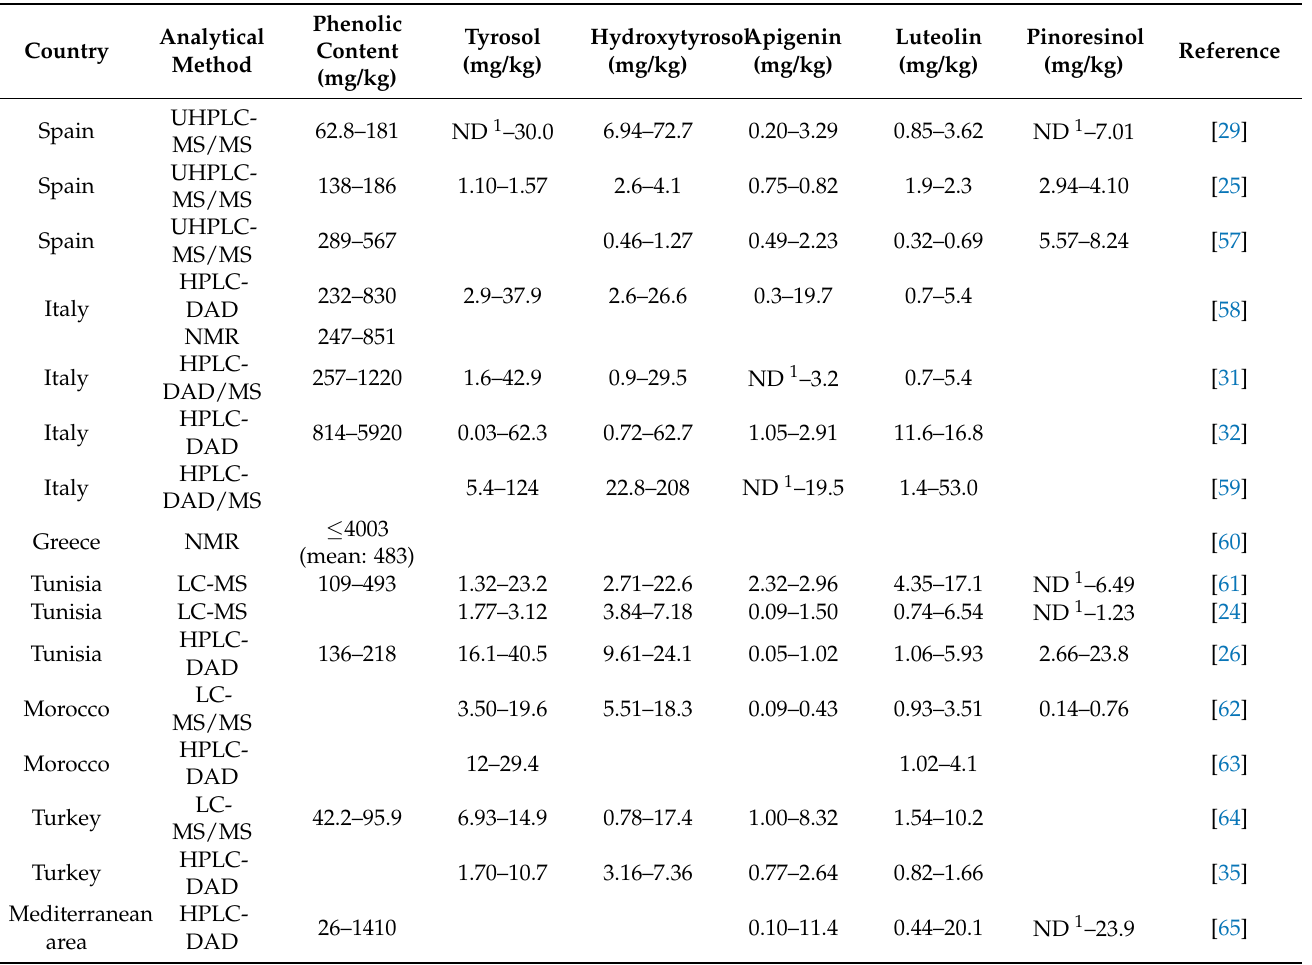
Table 4. Phenolic content and concentrations of tyrosol, hydroxytyrosol, apigenin, luteolin, and pinoresinol (mg/kg) in VOOs/EVOOs from Mediterranean